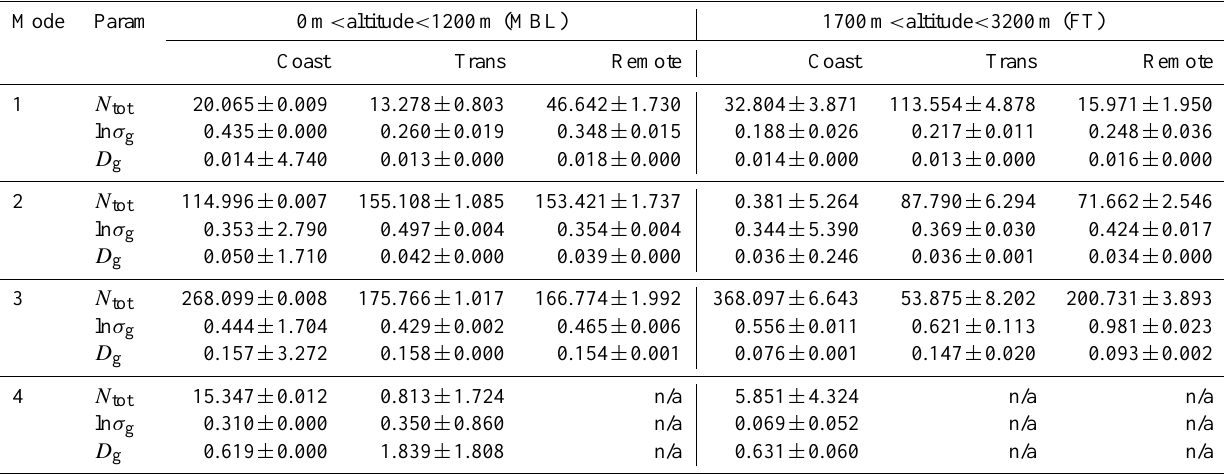
Table 4. Lognormal fit parameters to campaign-mean aerosol size spectra in each longitude zone below 1200m (MBL) and between 1700m and 3200m (FT). N tot is the particle number concentration (particles cm − 3 ), D is the particle diameter (µm), and D g and σ g are the number median diameter and the geometric standard deviation of the modal distribution, respectively. Errors quoted represent a one standard deviation uncertainty on the fitted parameter. All quantities are accurate to 3